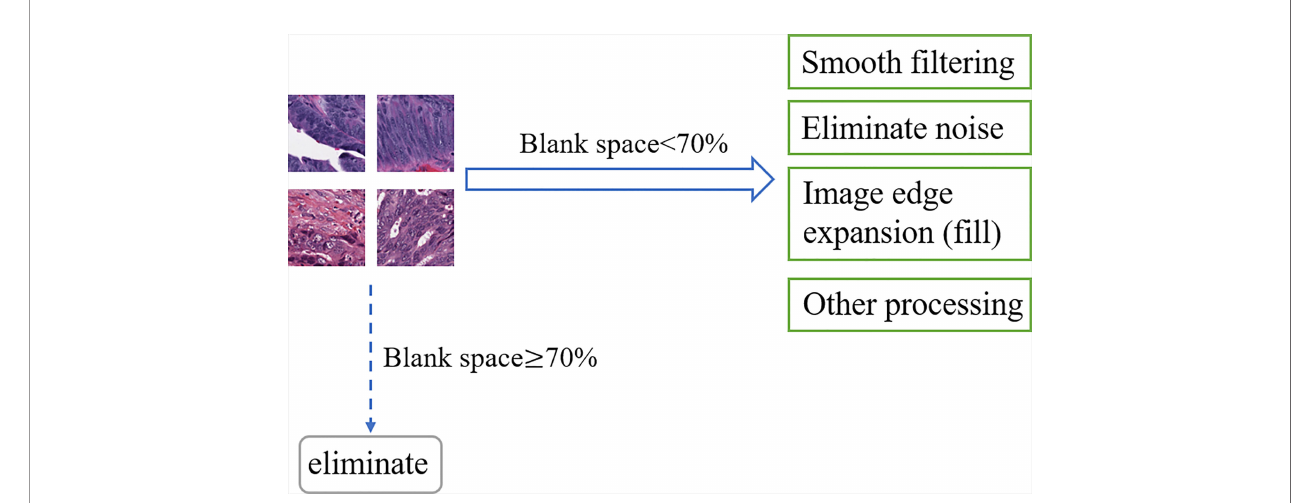
FIGURE 4 | OpenCV process.